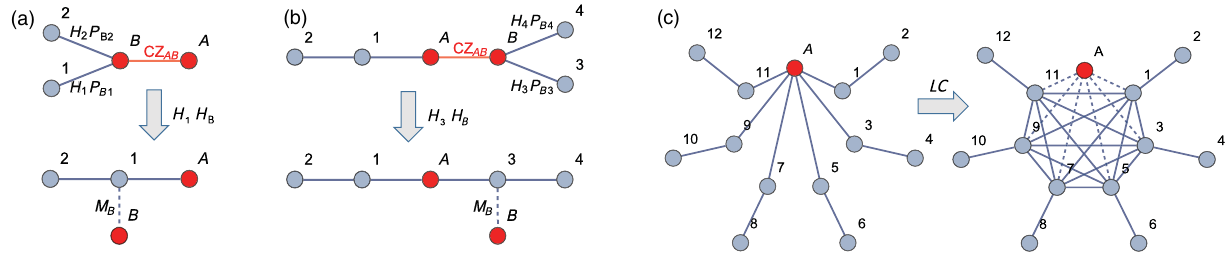
FIG. 3. Generation of the N ¼ 6 repeater state proposed in Ref. [16]: (a) Top: Emitter B is connected to ancilla A with a CZ gate and pumped twice, creating photons 1 and 2. Bottom: Hadamard gates are applied and emitter B is measured, detaching it from the graph. (b) This process is repeated (creating photons 3 and 4), generating another arm. (c) After N arms have been generated, local complementation is applied about ancilla A , and ancilla A is then measured. The exact sequence of gates for this process is given in the